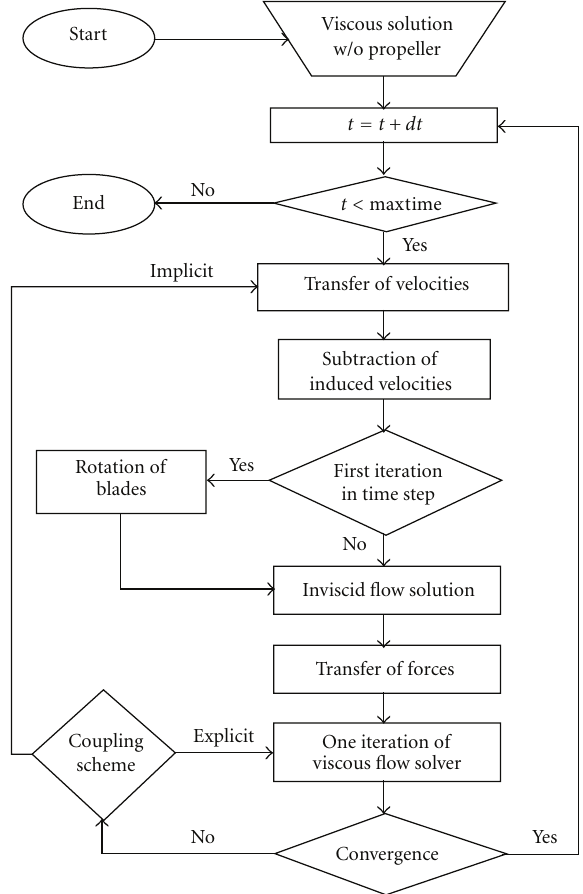
Figure 3: Flowchart of the employed coupling